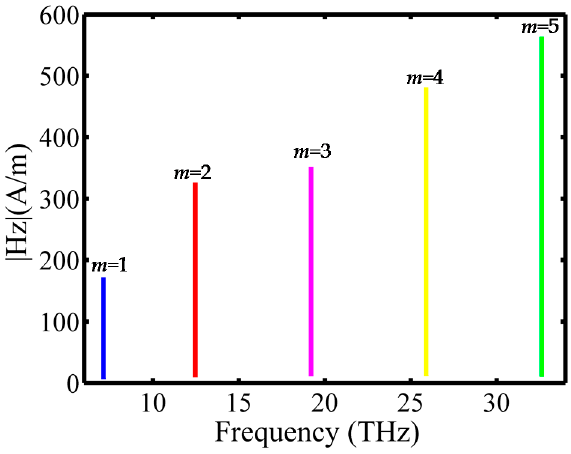
Figure 5. The resonant frequency spectrum. Table 1. Comparison of the eigenfrequency ( f e ) and the simulated resonant frequency ( f r ) for modes 1 to 8 of the GNW.